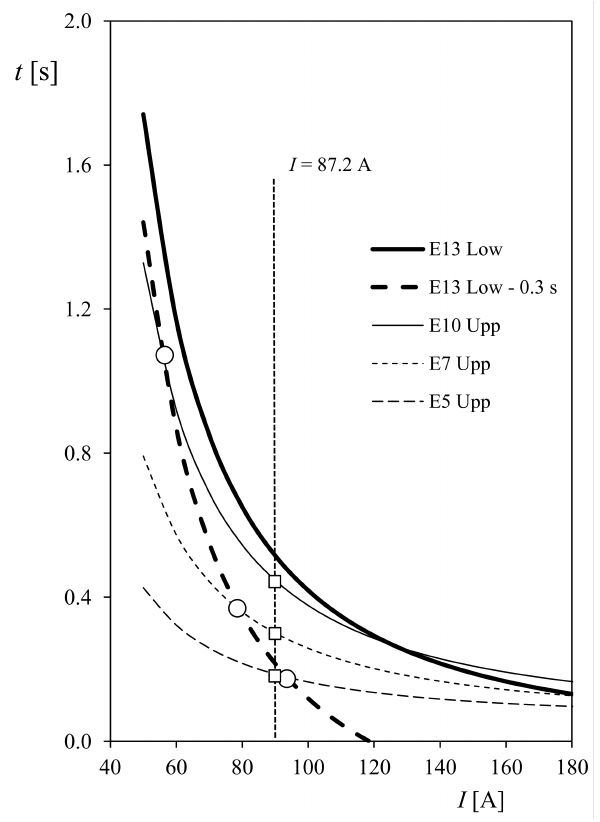
Figure 8. Selection of fuses to avoid the uncorrected coordination detected in case 23 of the calcula- tions considering PV nodes where the photovoltaic DG are installed. The lower tripping time curve, t EI , of SMD-50 E13 fuse selected for F3 fuse location (see Figure 6) is plotted, together with the upper tripping time curves, t ES , corresponding to SMD-50 E10, SMD-50 E7, and SMD-50 E5 fuses. The points of these curves corresponding to current I = 87.2 A obtained from the simulation of case 23 are indicated (open squares). The points corresponding to a proper coordination between fuse SMD-50 E13 as F3 with SMD-50 E10, SMD-50 E7, and SMD-50 E5 fuses as F4 are also indicated (open